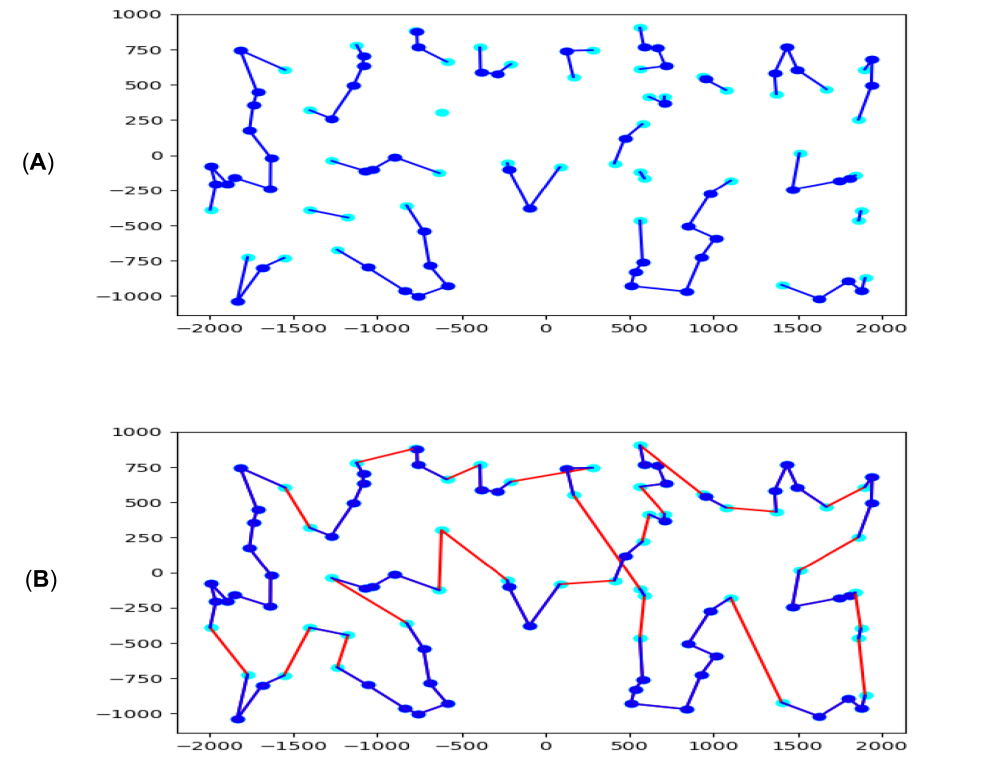
Figure 7. ( A ) The partial solution available at the end of the first phase for ML-SC. In light blue the remaining free vertices, and in dark blue the inserted edges. ( B ) The complete tour was found at the end of the ML-SC run. In red the edges were added during the second phase. The considered instance is the KroA100 from the TSPLIB